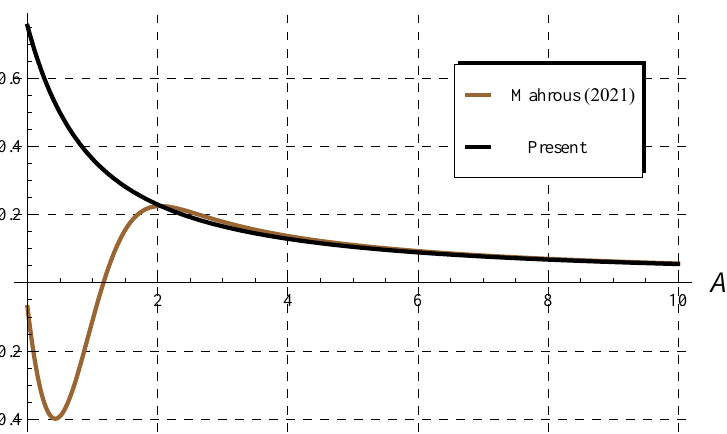
Figure 11. Comparisons between the present cup-mixing average concentration u av and the corre- sponding ones in Mahrous [7] at α = 1 (fractional chlorine decay), A 0 = 1.4, and A 2 = 0.1. 2